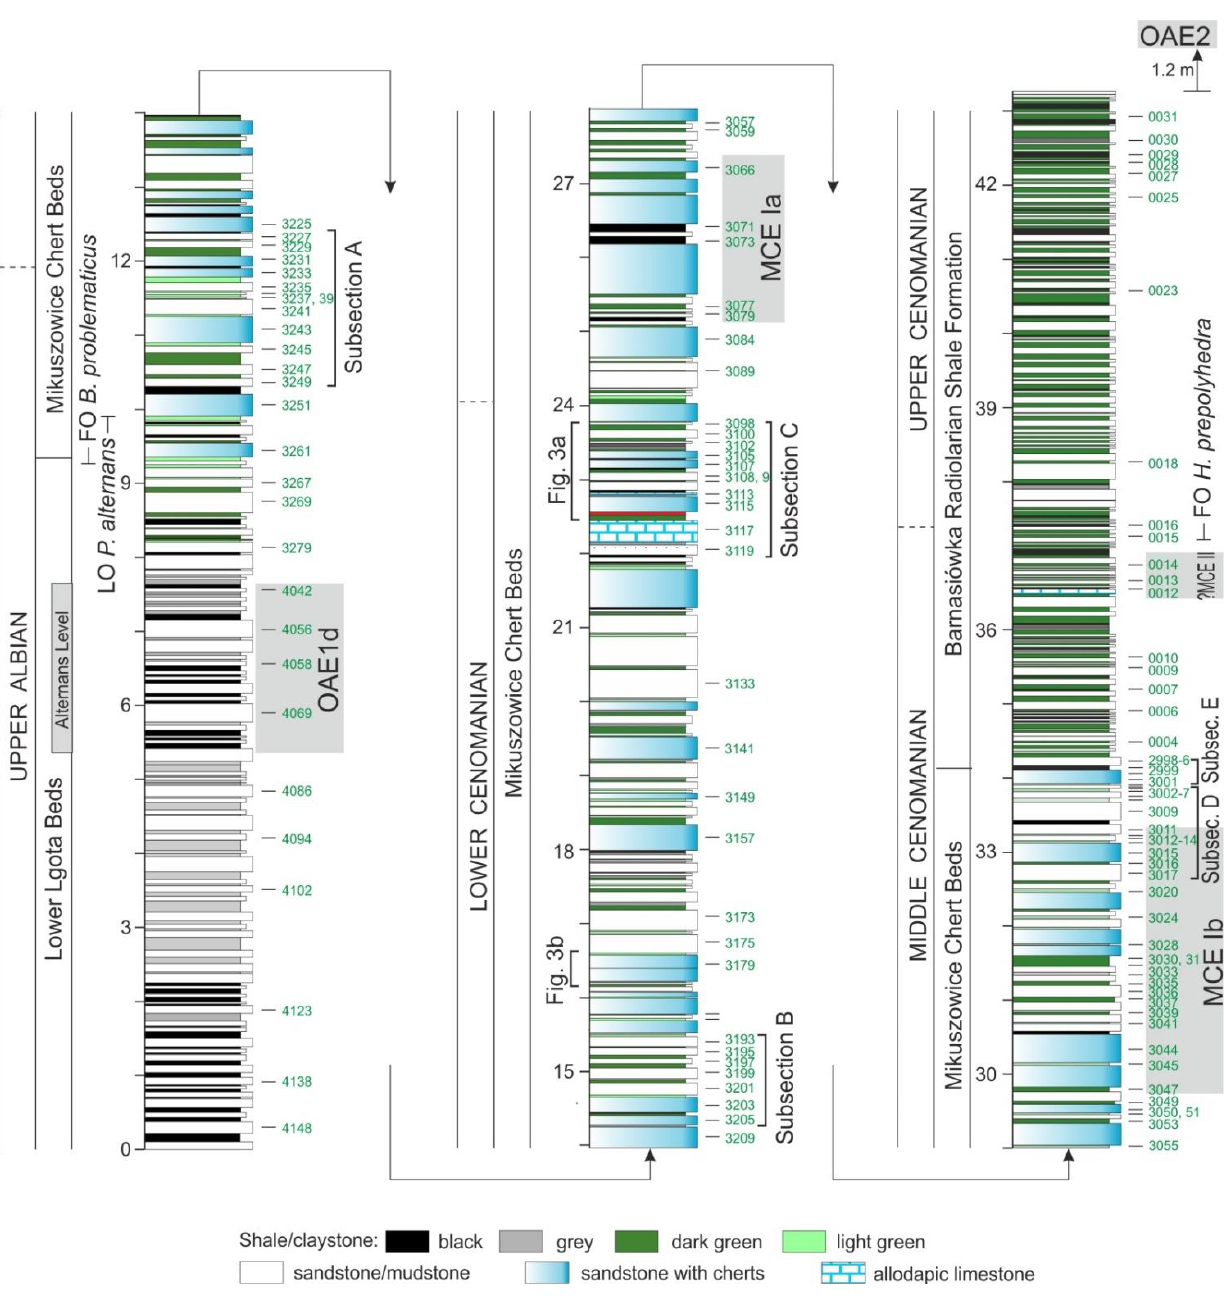
Figure 2. Lithological column of the Barnasiówka-Jasienica section with the position of five subsections (from A to E) studied in detail (microfacial studies in all successive micro-areas in thin sections), and with location of samples analyzed during this study. Correlation of sediments with isotopic events (OAE1d, MCE Ia, MCE Ib, and ?MCE II) is after [32].